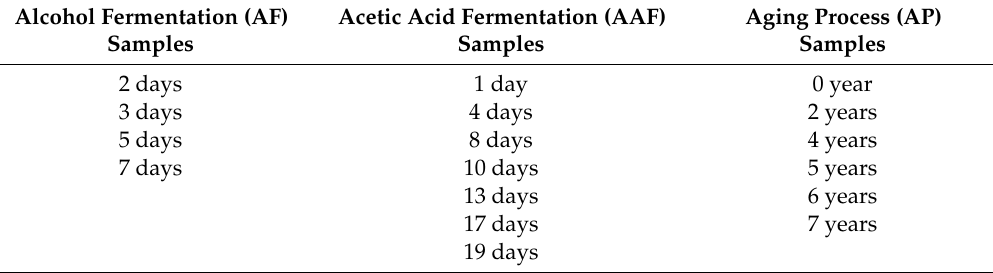
Table 2. The samples of ZAV during the brewing process 1